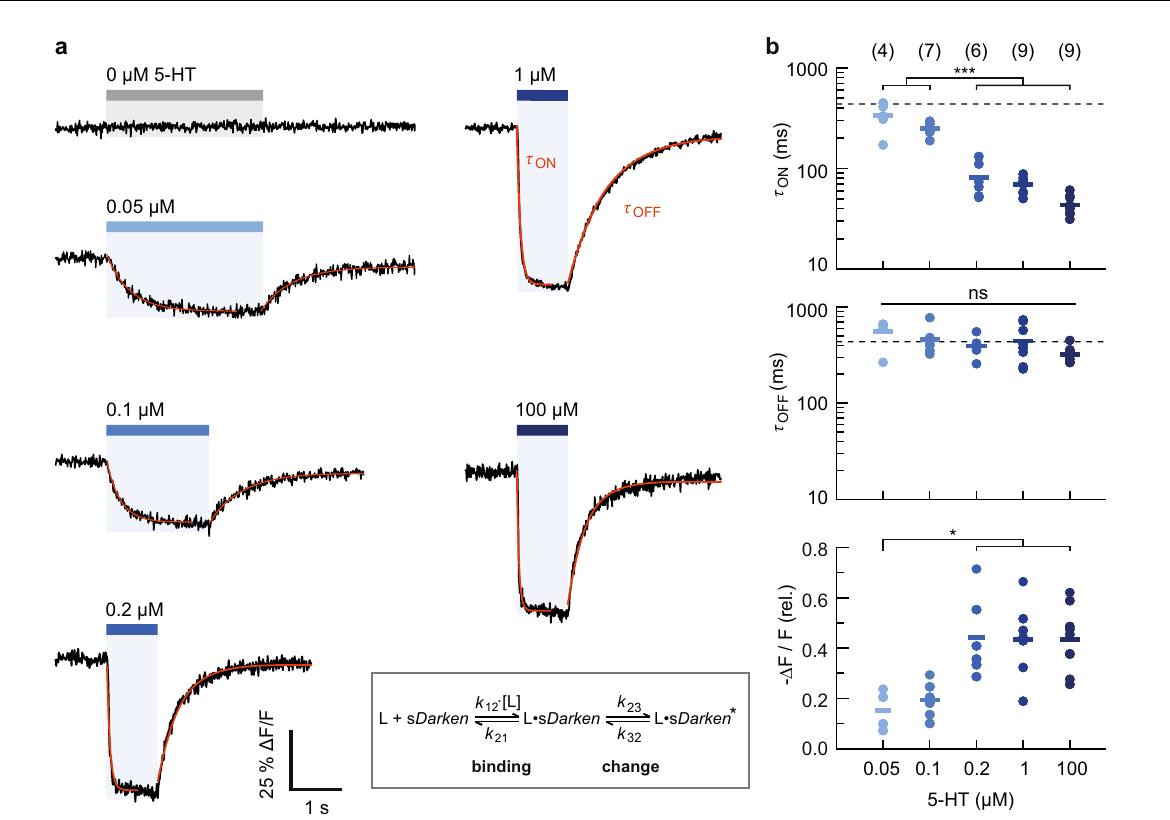
Fig. 2 | sDarken Sensor variants. a Expression of L-sDarken in HEK cells. Fluores- cence before and after the application of 160 µ M 5-HT. Scale bar 10 µ m. b Expression of H-sDarken in HEK cells. Fluorescence change before and after the application of 800nM 5-HT. Scale bar 10 µ m. c Dose response curve of sDarken , L-sDarken and H-sDarken measured in response to different 5-HT concentrations. Group data n =20 from 3 replicates. Error bars represent ±SEM. d (i) Fluorescence change of L-sDarken to application of serotonin (160 µ M), similar substances or neurotransmitters, if not mentioned differently 10 µ M were applied ( n =10). 8-OHDPAT 300 µ M. (ii) Fluorescence change of H-sDarken to application of ser- otonin, similar substances orneurotransmitters if not mentioned differently10 µ M were applied ( n =10). Box represents the 25% percentileto the 75% percentile. The